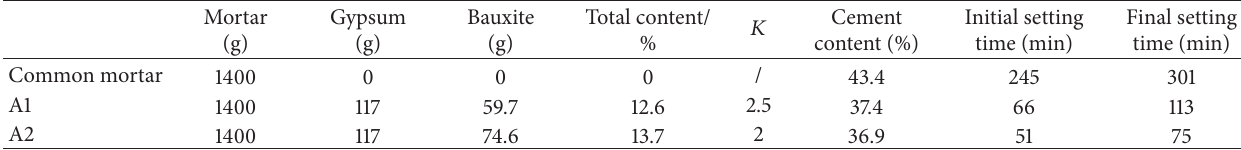
Table 8: Mineral content and setting time of gypsum-bauxite grouting mortar.